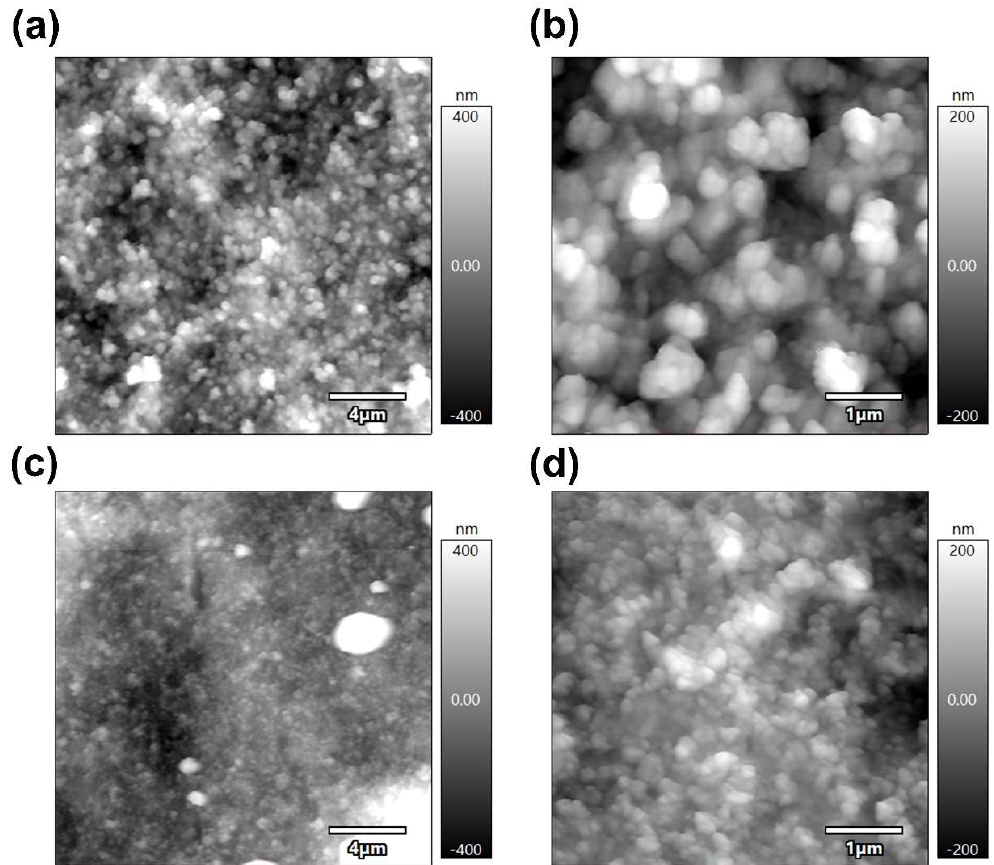
Figure 7. Amplitude modulation mode topography images of ( a , b ) MnB − I and ( c , d ) MnB − II. Table 2. The resistance of each sample/region as determined from C-AFM IV measurements ( n = 20).